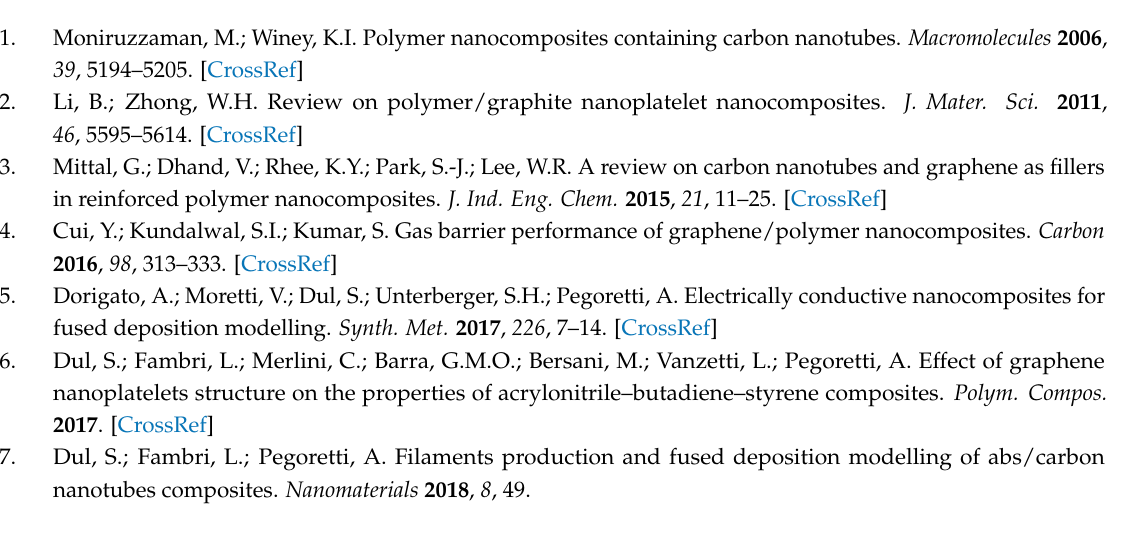
Figure S1: Representative stress-strain curves of ABS and ABS nanocomposites with (a) graphene and (b) carbon nanotubes, Figure S2: Creep compliance curves of (a) ABS matrix and nanocomposites with (b) GNP-6 or (c) CNT-6 under applied load of 3.9 MPa at different temperatures in the range 30–90 ◦ C, Figure S3: Comparison of the parameters P E , ρ encompassing the effects of elastic modulus and resistivity of nanocomposites, as function of the nanofiller fraction up to 8 wt % (see Equation (21)), Figure S4: Comparison of parameters P E,M, ρ encompassing the effects of elastic modulus, melt flow index (at 220 ◦ C and 10 kg) and resistivity, as function of nanofiller fraction up to 8 wt % of CNT or 30 wt % of GNP (See Equation (22)), Table S1: Summary of representative properties of ABS matrix and its composites with GNP-M5 or CNT nanofillers. The values for filler fractions 2 wt % and 8 wt % are calculated by using Equations (S1) and